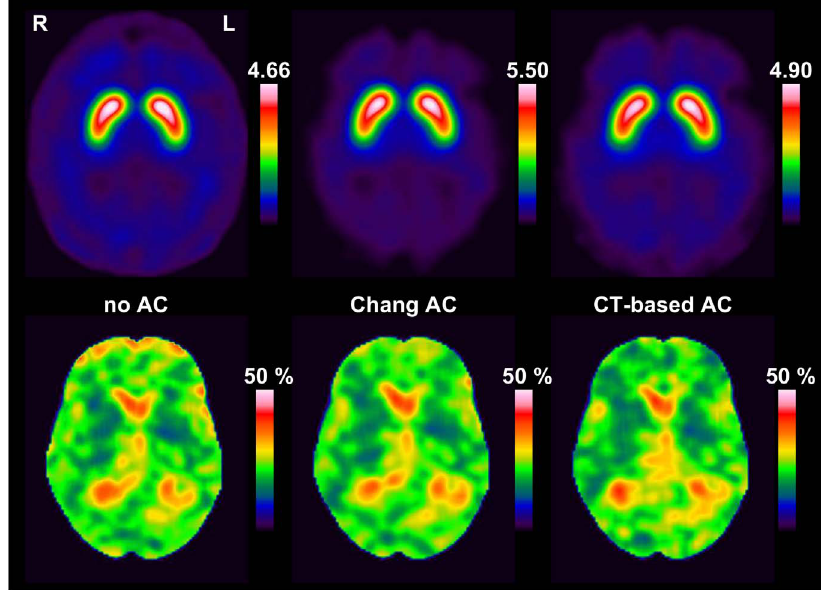
Figure 6. Image quality. Slab of 12 mm thickness of the scaled, stereotactically normalized I-123-ioflupane SPECT averaged over all patients with normal DAT availability ( top ). Slab displaying the coefficient of variation (%) of the DVR over all patients with normal DAT availability ( bottom ).